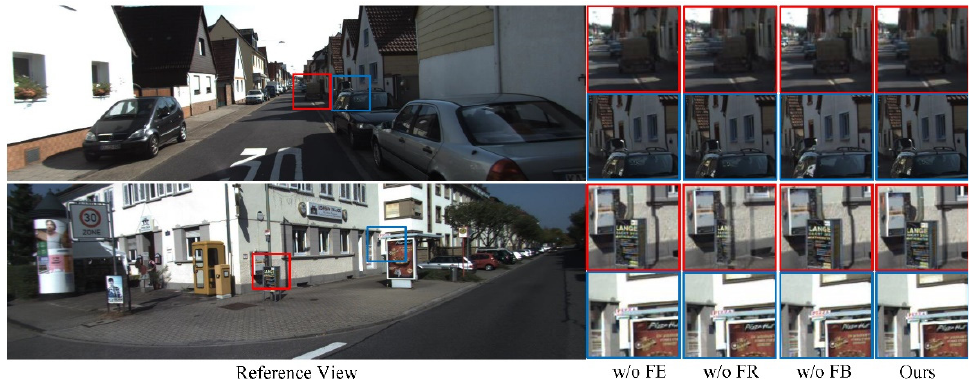
Figure 7. Taking the right view as the reference view for the ablation experiments to verify the effectiveness of flow estimation (FE), flow-based reconstruction (FR), and flow-based blending (FB). Flow-based reconstruction (FR): Due to parallax, the baseline and rough estimation